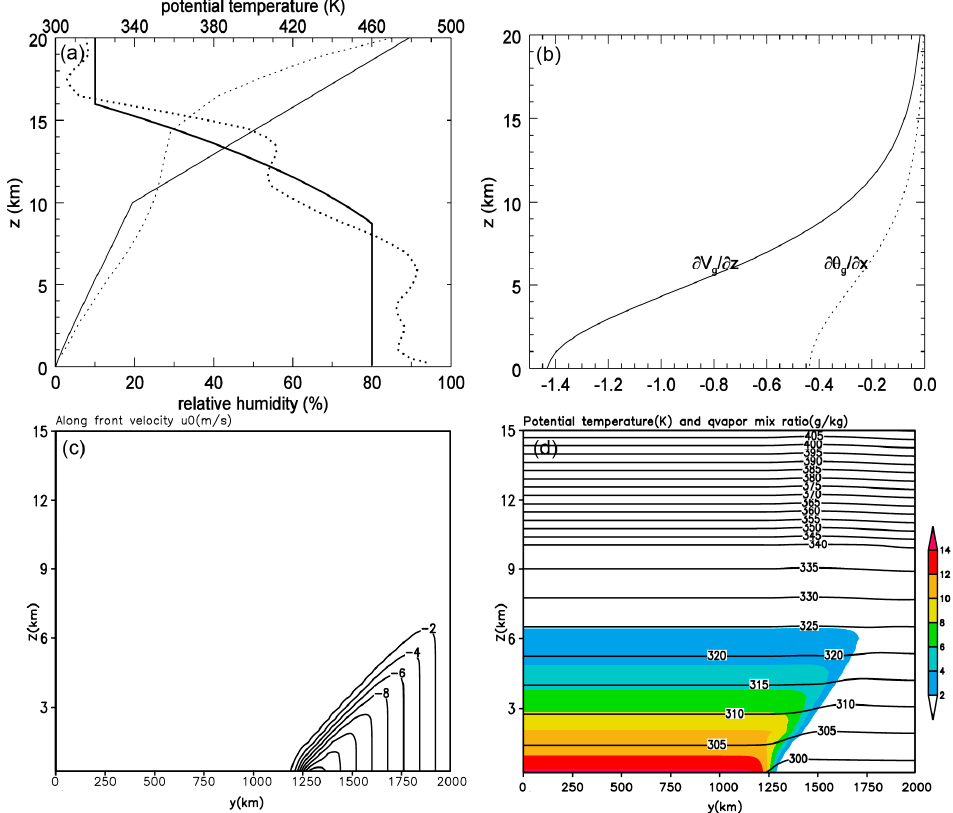
Figure 1. ( a ) Average initial measured (Dotted Line) and ideal model (Solid Line) potential temperature fields plotted together with the basic-state relative humidity field (thin lines are Potential temperature, thick lines are relative humidity) for the region [110°–125 ° E, 28 ° –32 ° N] on 12 July 2010 at 00 UTC. ( b ) Vertical profiles of the vertical shear of the meridional geostrophic wind ( ∂ V g / ∂ z , solid line, Units: 10 − 3 s − 1 ) and the large-scale zonal gradient of the potential temperature ( ∂θ g / ∂ x , dotted line, Units: K / 100 km). ( c ) Velocity profile along the frontal boundary ( u 0 , isolines, 2.0 m s − 1 intervals) and ( d ) potential temperature profile ( θ 0 , isolines, 5 K intervals) plotted with water vapor mixing ratio ( q v 0 , shaded, 2 g kg − 1 intervals).